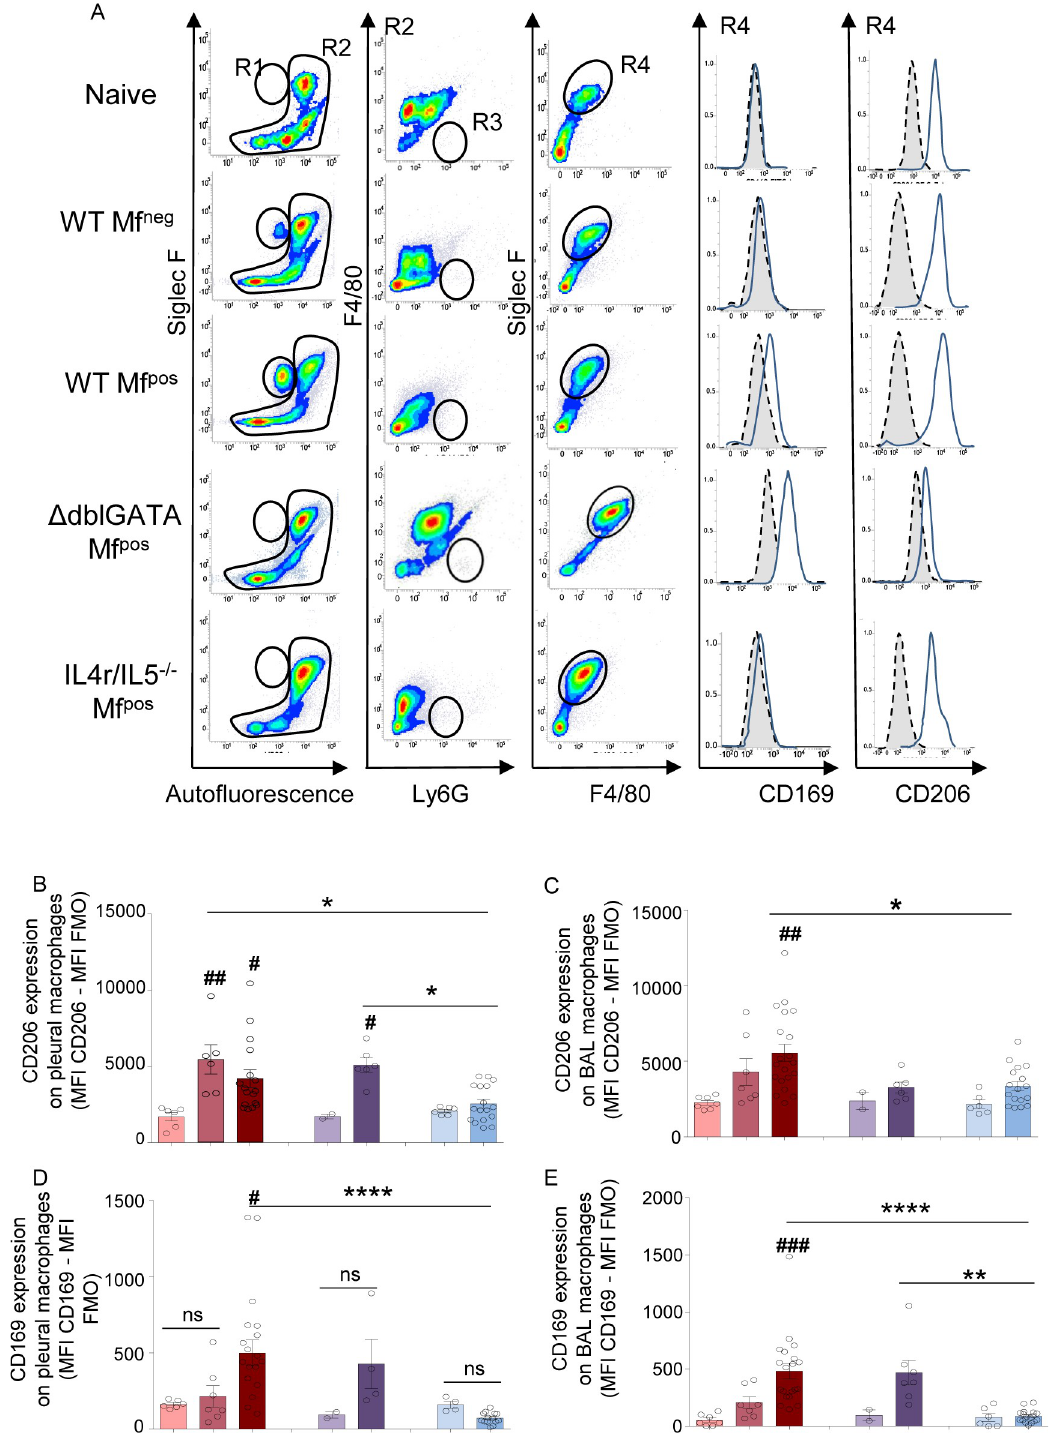
Fig 7. Activation of macrophages in infected mice is dependent on IL-4R and/or eosinophils. Pleural and bronchoalveolar cells were isolated from L . sigmodontis infected WT, Δ dblGata1 and Il-4ra -/- /Il-5 -/- BALB/c mice at 70 days p.i. Macrophage activation (CD206 and CD169 expression) were analyzed by flow cytometry. ( A ) Representative plots and curves showing the gating strategy for bronchoalveolar cells stained with anti-SiglecF-PE, anti-F4/80-APC, anti-Ly6G-V450, anti-CD169-FITC and anti- CD206-PE-Cy7. Doublets and dead cells were excluded prior further analysis. R1 = SiglecF + eosinophils. R2 = Non-eosinophil cells. R3 and R4 were defined from the R2 population: R3 = Ly6G + neutrophils; R4 = F4/80 + macrophages; CD206 and